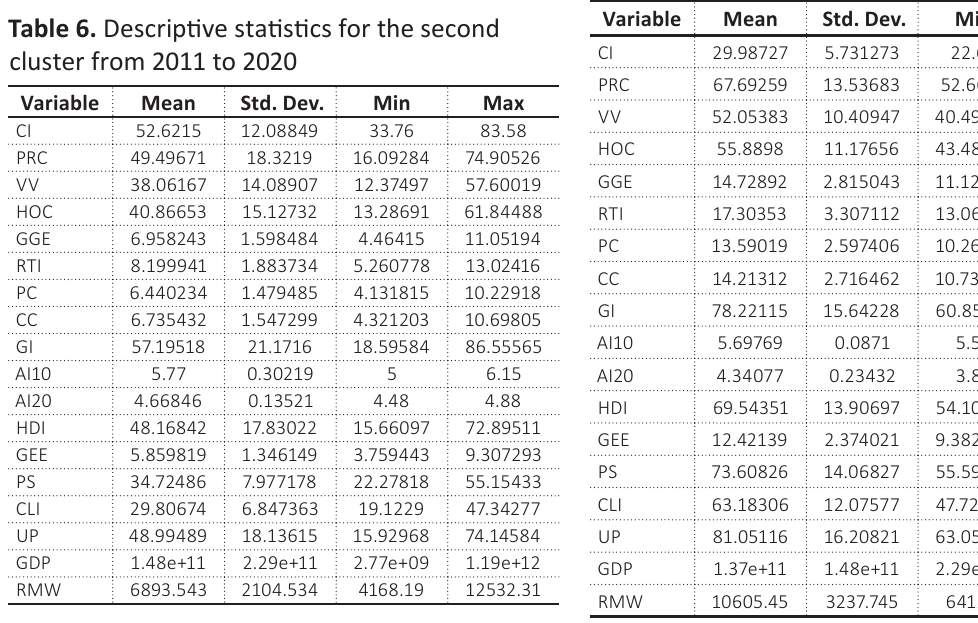
Table 8. Descriptive statistics for the